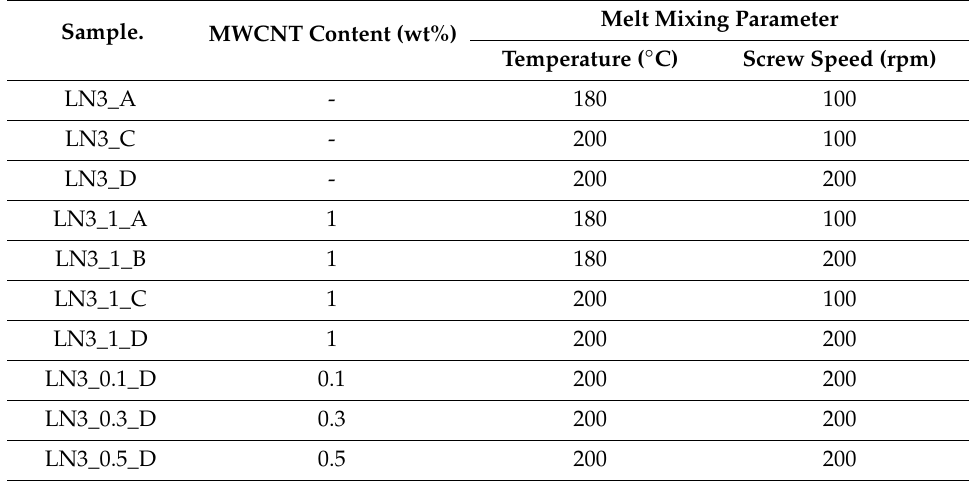
Table 2. Processing conditions of LN3 and LN3 / multiwalled carbon nanotubes (MWCNT) composites.